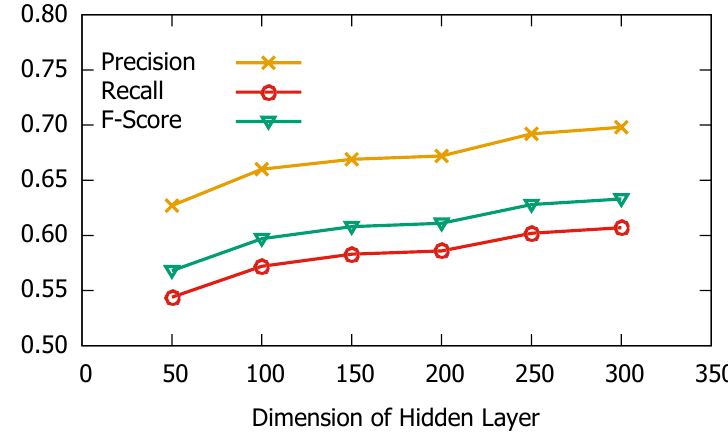
Figure 19. Results of Tree-LSTM with dimension of hidden layers range from 50 to